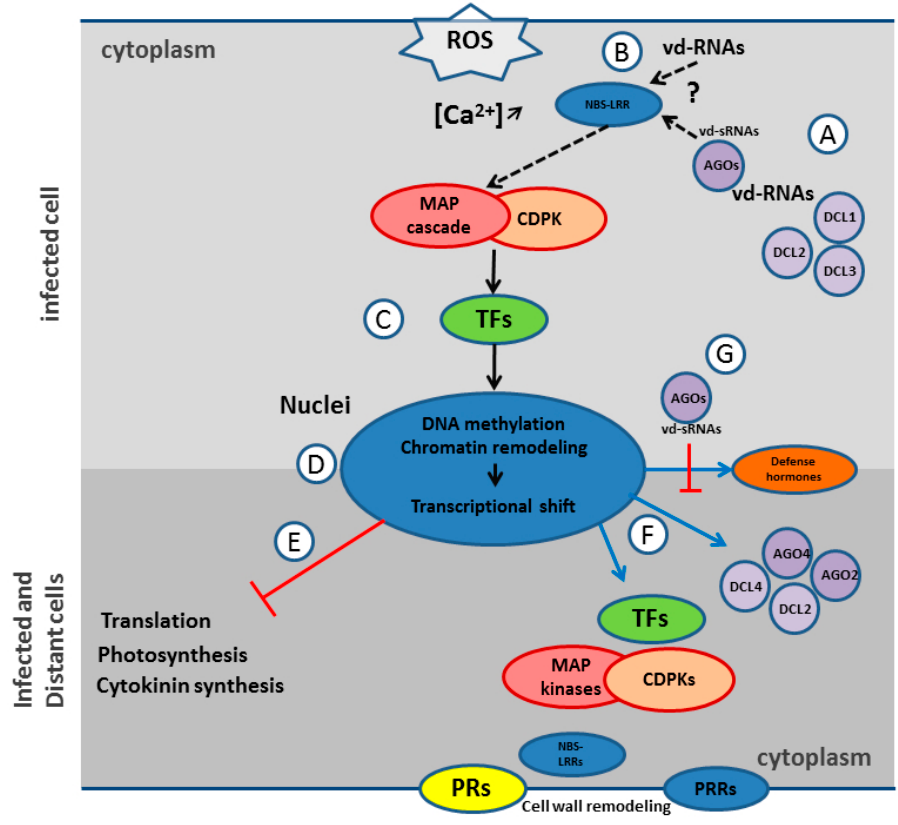
Figure 5. Hypothetical and simplified model of innate immunity and SAR activation by pospiviroids: ( A ) In infected cells, the viroid derived RNAs (vd-RNAs) are degraded by Dicer-like (DCL) 1, 2, and 3 into viroid-derived small RNAs (vd-sRNAs) which are loaded in argonautes (AGOs) to further degrade vd-RNAs. ( B ) vd-RNAs or AGOs loaded with vd-sRNAs are recognized directly or indirectly by nucleotide-binding site leucine-rich repeat (NBS-LRR) proteins which trigger effector-triggered immunity (ETI). ( C ) After reactive oxygen species (ROS) production and Ca 2+ cytoplasmic influx, MAP kinase cascade (MAP cascade) and calcium-dependent protein kinases (CDPK) activate transcription factors (TFs), which transduce the innate immune signal. ( D ) Host DNA undergoes methylation and chromatin remodeling which lead to a massive transcriptional shift. ( E ) This shift induces a repression of translation, photosynthesis, and cytokinin biosynthesis, which leads to symptoms. ( F ) This shift also induces the systemic activation of immunity defenses through the overexpression of innate immunity related proteins ranging from pathogen sensors, e.g., pattern recognition receptors (PRRs) and NBS-LRRs, to signal transductors, e.g., MAP kinases, CDPKs, TFs, and defense hormones, and eventually, to defense proteins, e.g., RNAi machinery, PR genes, and cell wall remodeling proteins. ( G ) As counter-defense, pospiviroids contain specific sequences in their genome which, when present in vd-sRNAs and loaded in AGOs, trigger the PTGS degradation of mRNAs involved in dedicated defense.